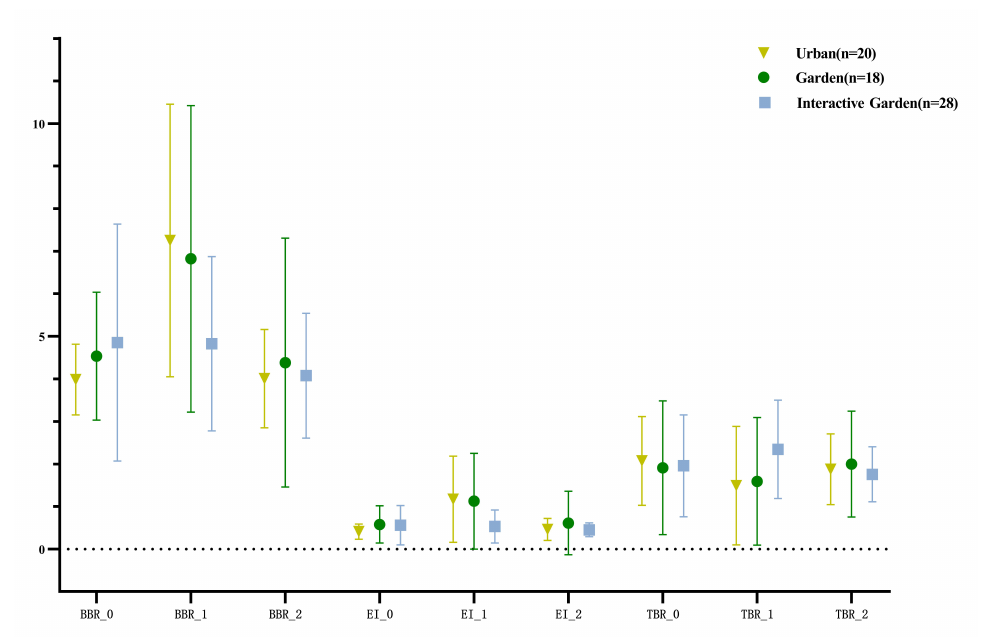
Figure 11. Descriptive statistical results of PSD calculation